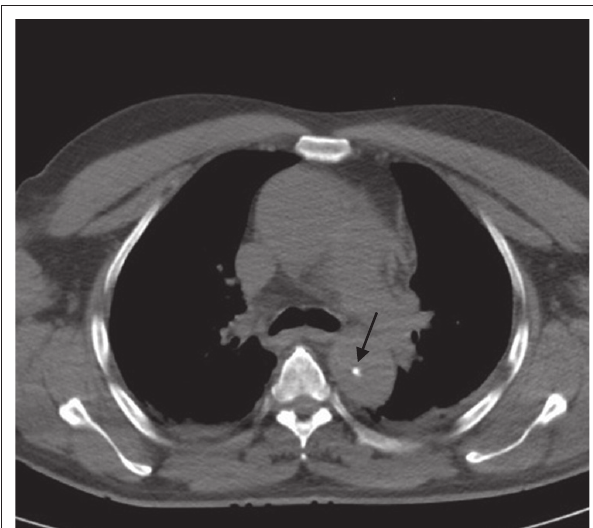
FIGURE 1: Axial unenhanced computed tomography scan of thorax demonstrating displaced intimal calcification (arrow), suggesting aortic dissection.